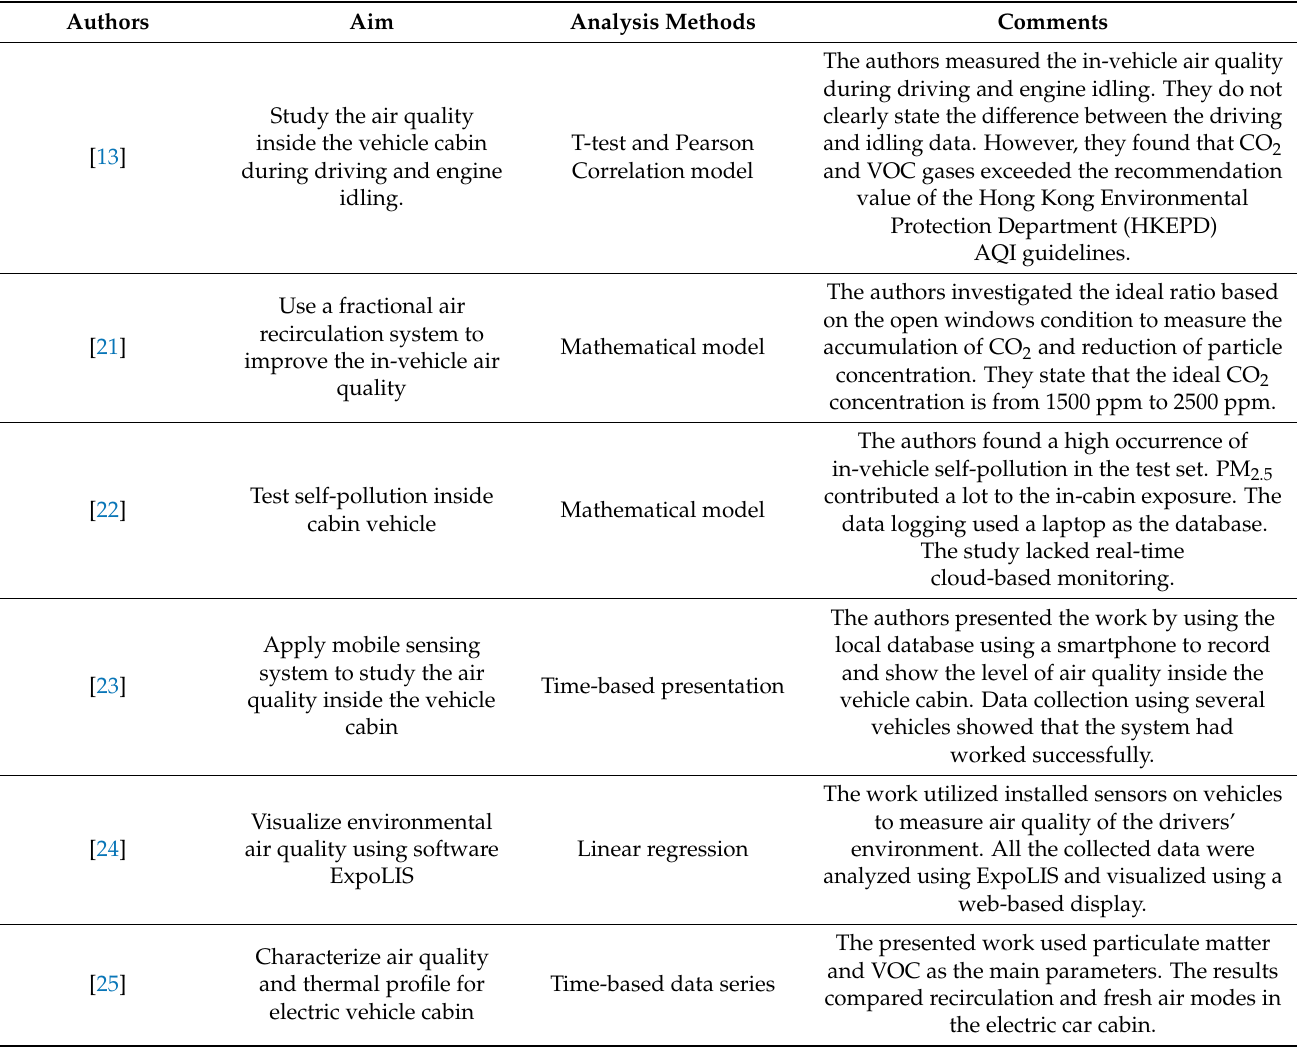
Table 1. Related Work on In-vehicle Air Quality